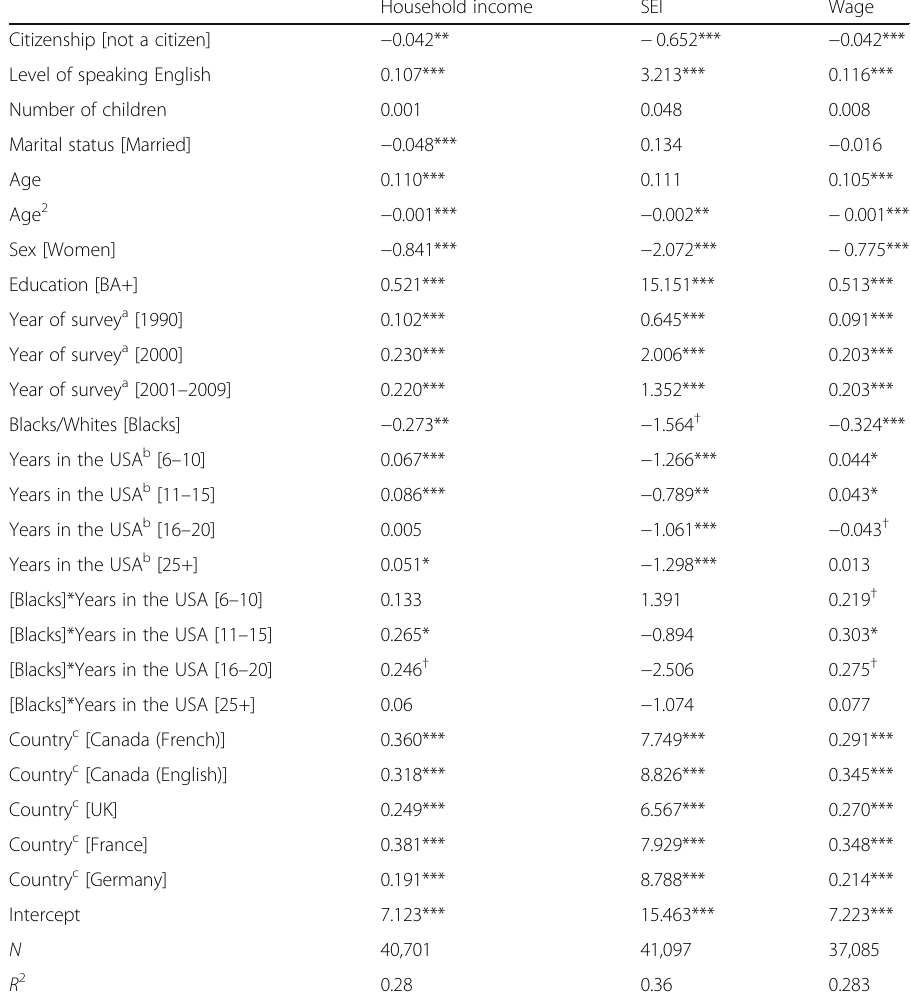
Table 8 Full regressions of economic characteristics for immigrants to the USA, age 25 to 64, interaction of race with years in the USA Household income